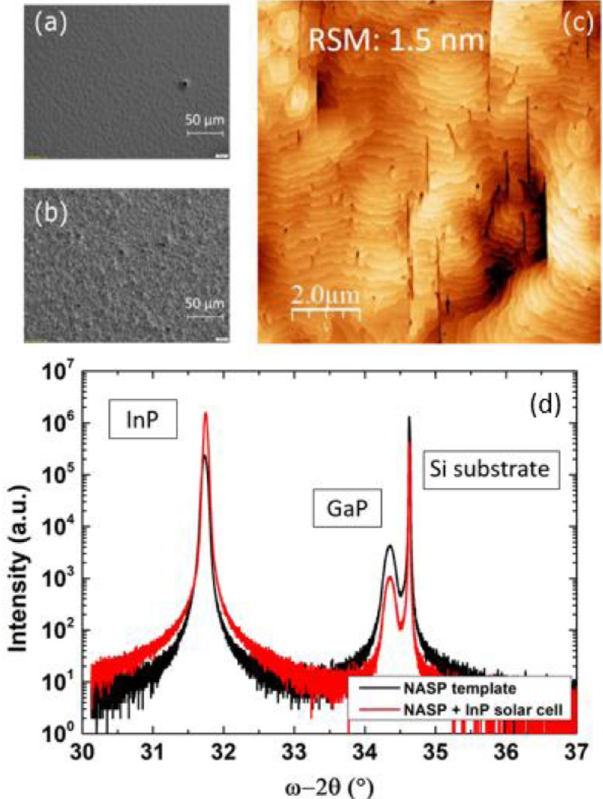
Fig. 8. InP solar cell grown onto NAsP template: morphology (a) At the center and (b) At the edge of the sample from optical microscopy; (c) AFM; (d) XRD scans of NAsP template (black line) and NAsP+ InP solar cell (red